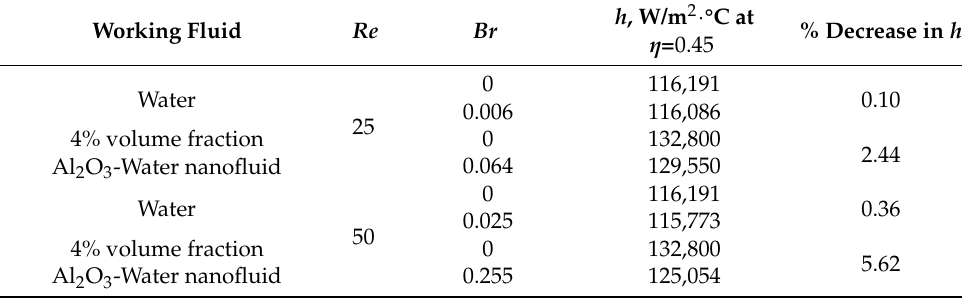
Table 5. Comparison of heat transfer coefficient for a composite